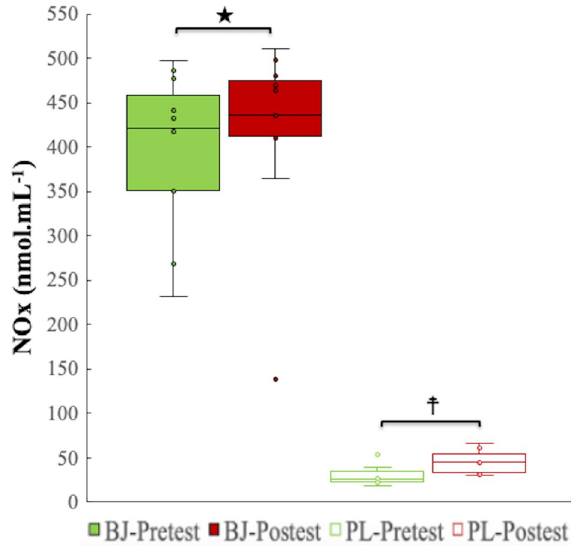
Figure 3. Circulating NOx concentrations in plasma. BJ, beetroot juice; NOx, nitrate plus nitrite; PL, placebo. ★ A significant raise in plasma NOx concentrations after BJ intake compared to PL in pretest and